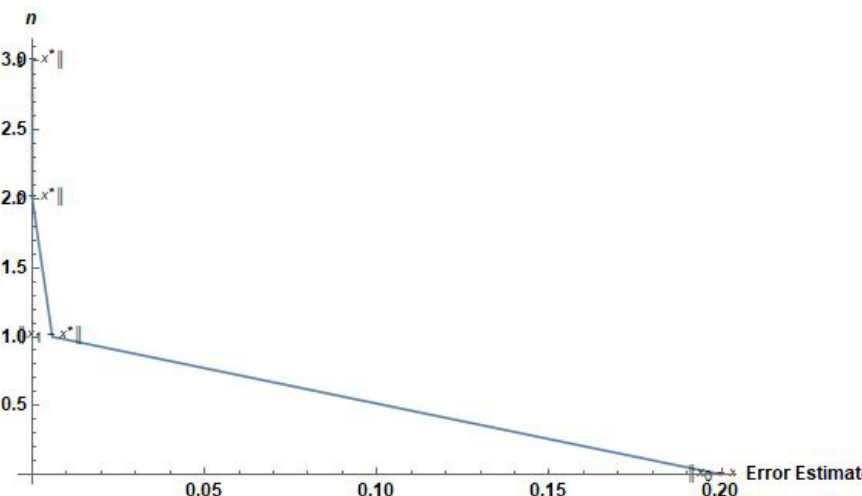
Figure 1. Graph of G ( t ) = t 3 ln ( t 2 ) + t 5 − t 4 .